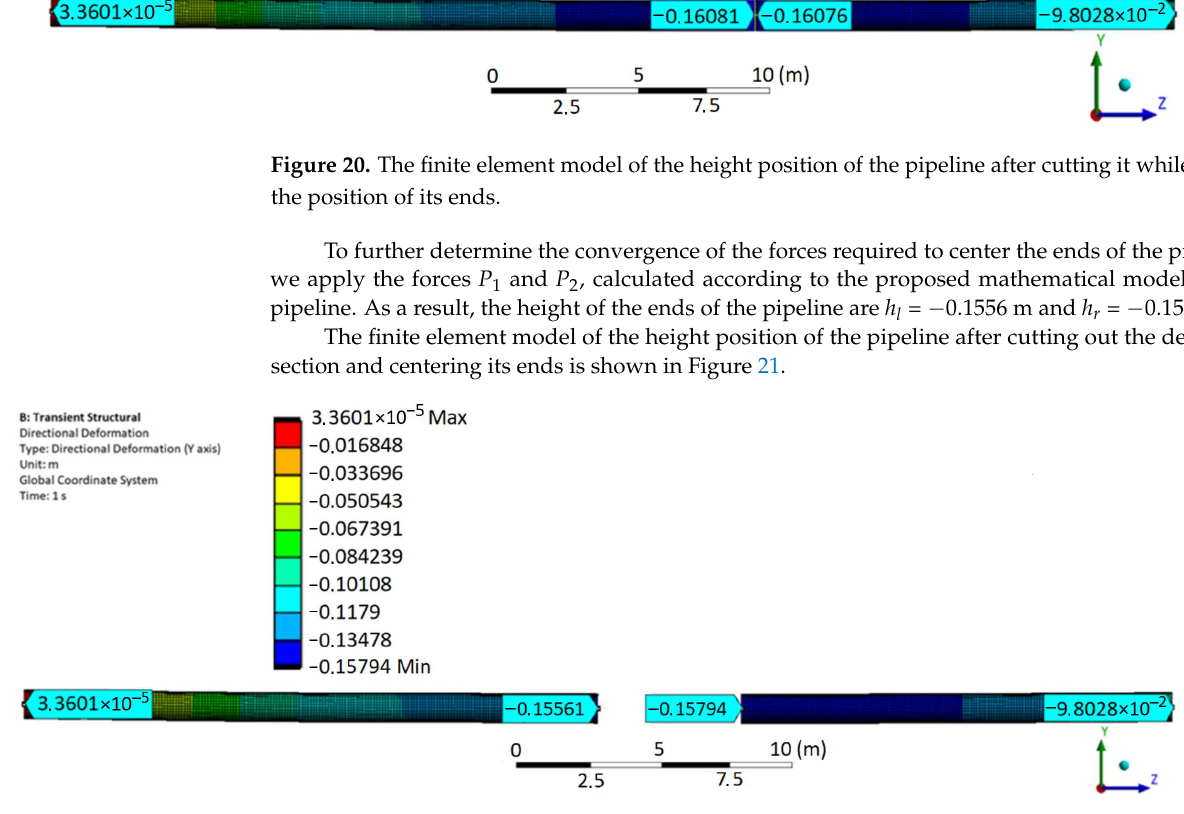
Figure 21. The finite element model of the height position of the pipeline after cutting out the defective section and centering its ends. Table 5. The results of the calculation of the reaction forces arising in the hydraulic cylinders of the devices when fixing the position of the modeled pipeline, and the forces required to center its ends. The Value According to the Proposed Math- Parameter ematical Model